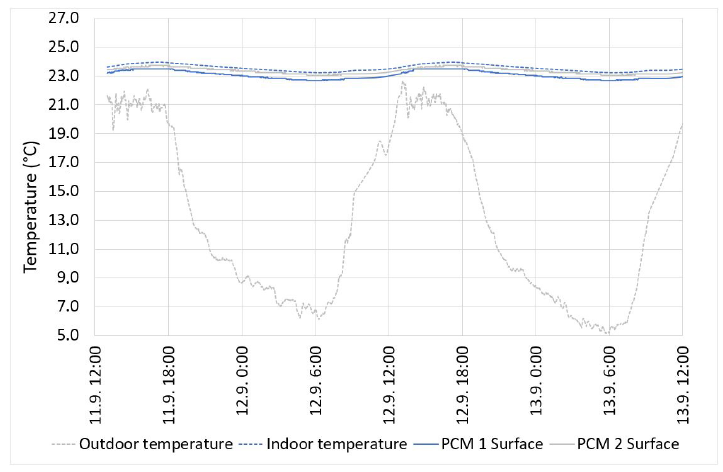
Figure 8. Passive mode.